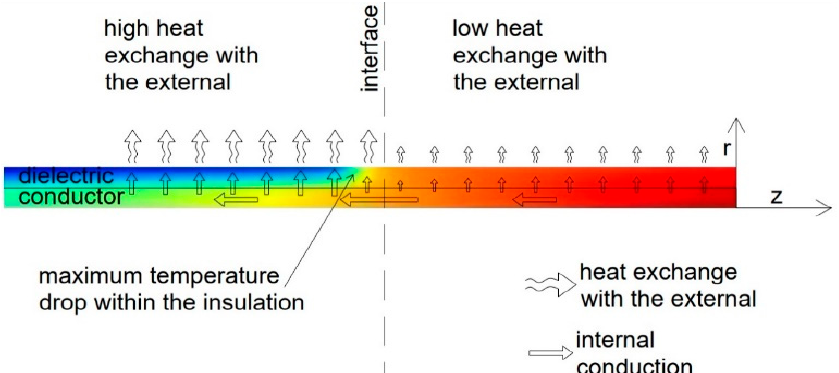
Figure 1. Schematic of prevalent axial conduction close to an interface between two external means.